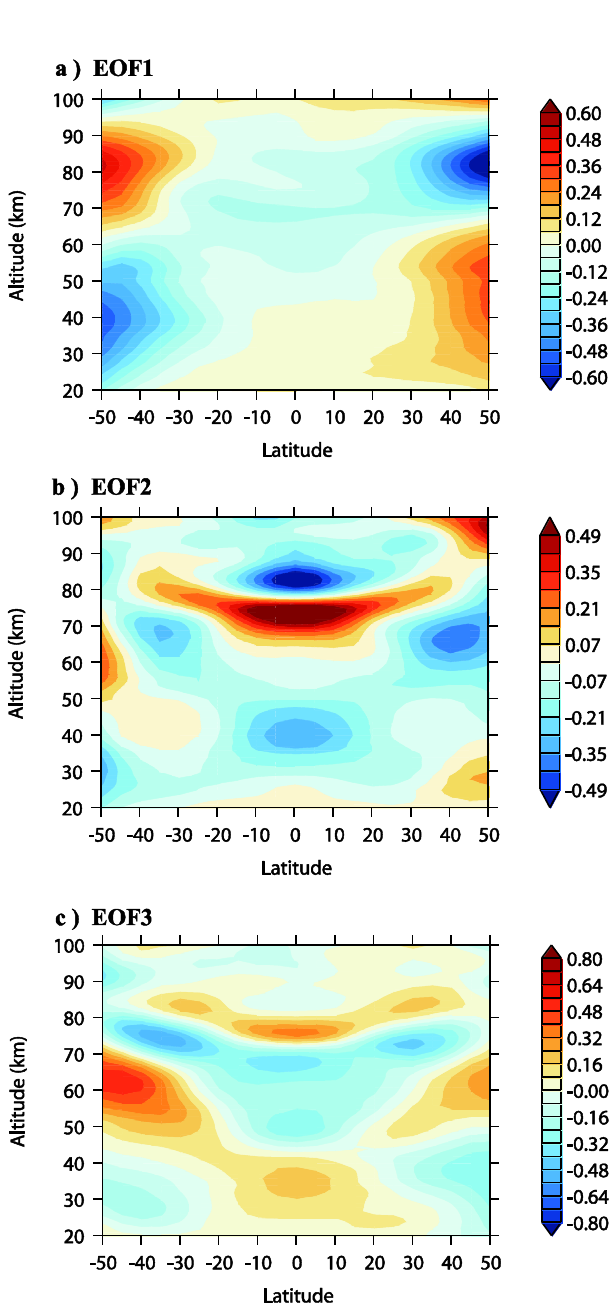
Fig. 2. (a–c) The first three EOFs of the SABER data Figure 2. (a-c) The first 3 EOFs of the SABER data anomalies. 406